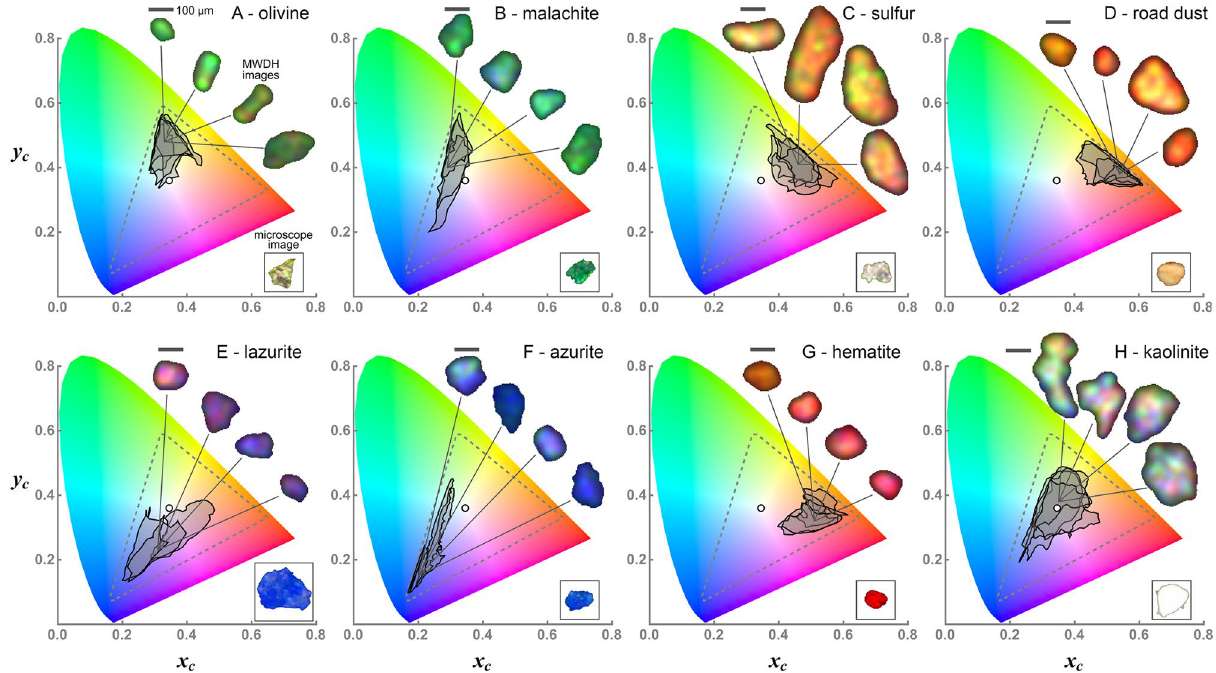
Figure 4. Chromaticity analysis of a variety of free-flowing mineral dust aerosol particles. Each panel shows the backscatter MWDH image of the particles associated with their chromaticity signatures. Each particle-image corresponds to a separate measurement. A 100 µ m scale bar is shown along with an optical microscope image, in frame, of a representative particle taken from the stock powder from which the aerosols are generated, see also Fig. overlapping. The overlap indicates that the images possess similar color content despite the variation in overall brightness of the images shown. Malachite is shown in Fig. 4B, where again we see overlap of the signatures, mostly green, but also some variability indicating that the images exhibit a degree of blue content. Progressing though the other materials in Fig. 4, one sees the aerosol signatures continue to evolve in their location in the color space. Overall, the backscat- ter MWDH images display a similar color content as the microscope images, although with notable exceptions. For example, the kaolinite images in Fig. 4H show a comparatively large signature surrounding the white point.